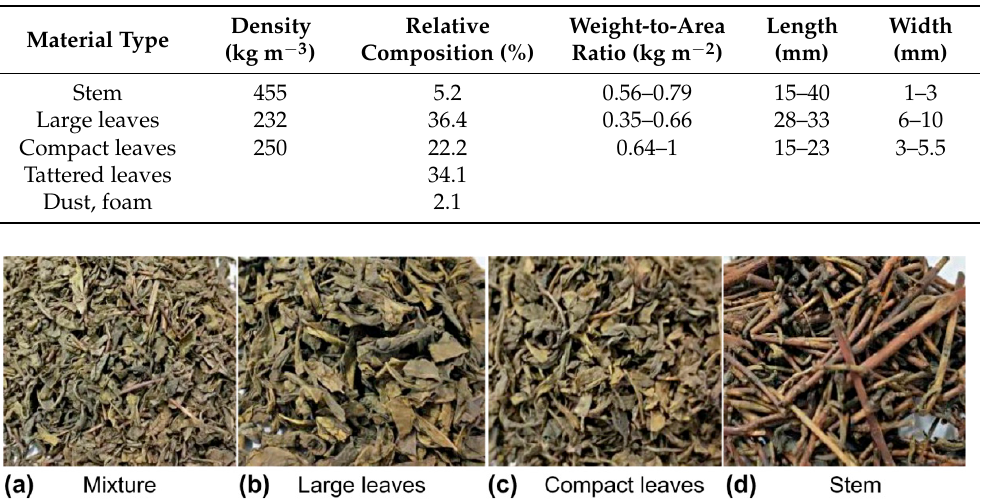
Table 1. Physical parameters of tea materials.